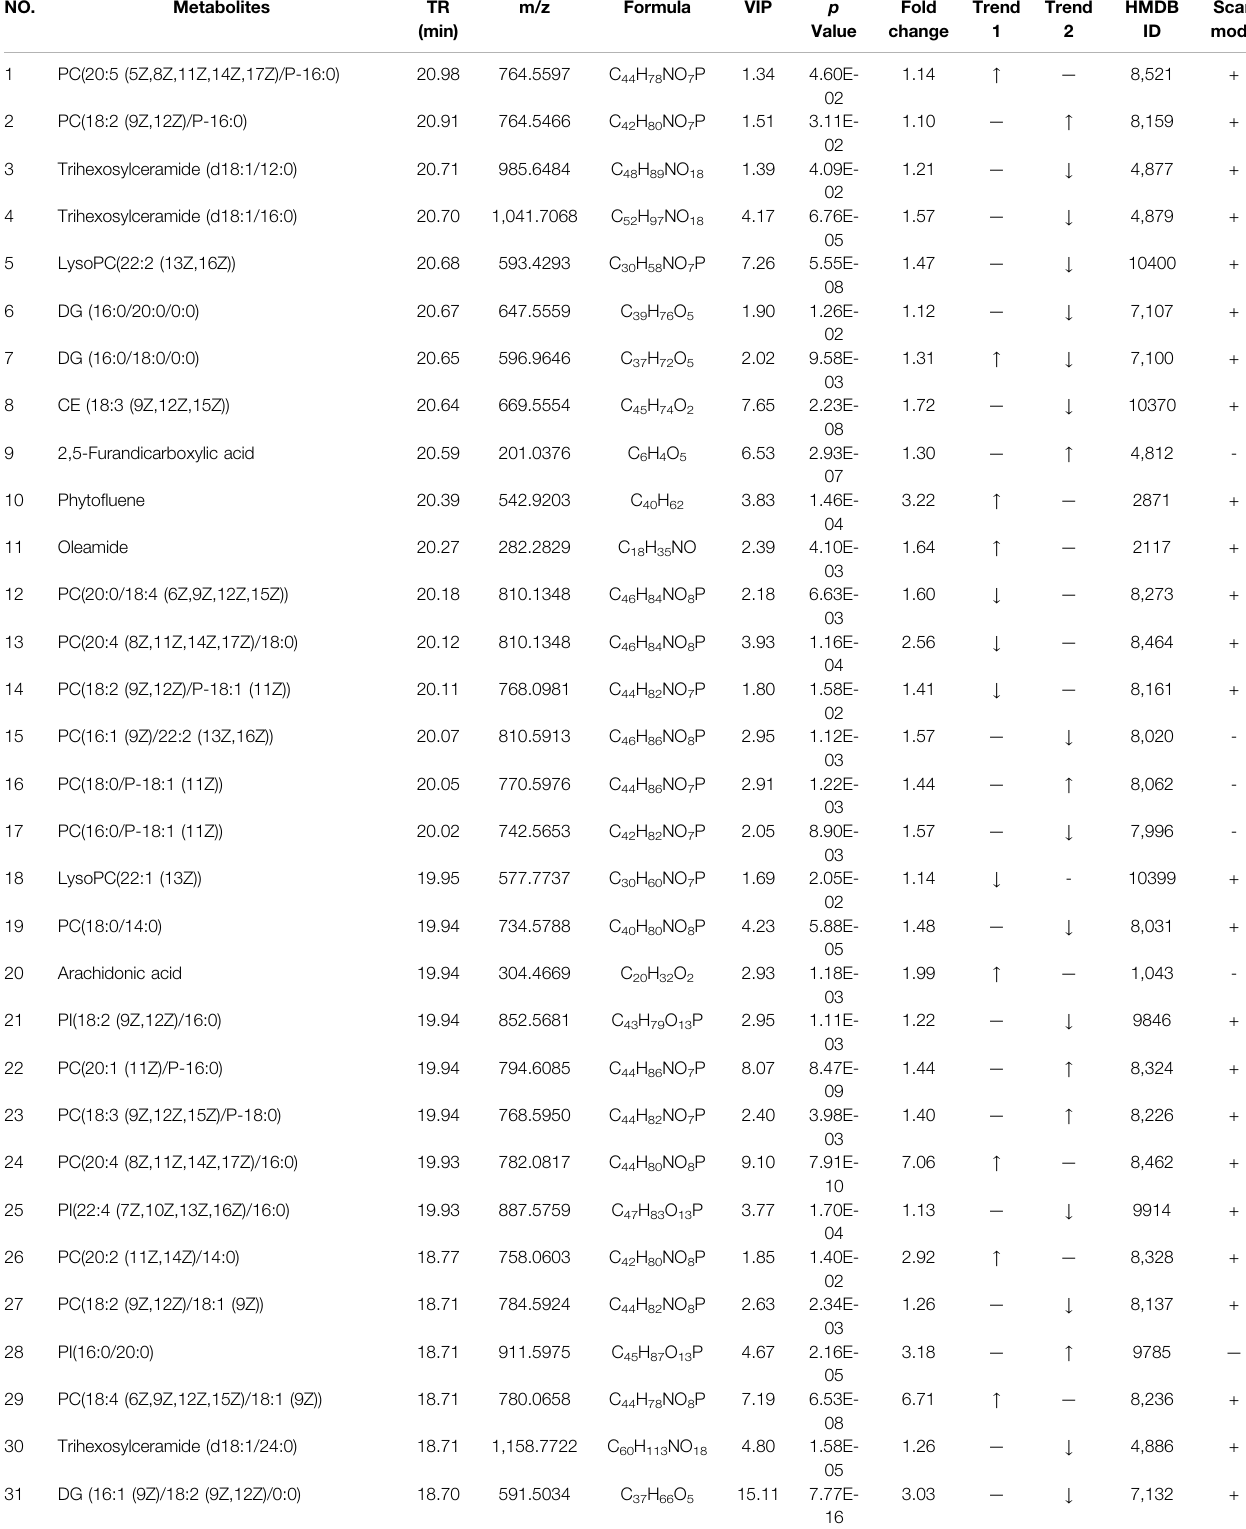
TABLE1| DetectionofBDS-relatedMetabolitesinPlasmabyLC-MS.Trend1isControlgroupcomparedwithModelgroup;Trend2isModelgroupcomparedwith5-HML- L group. NO. Metabolites TR